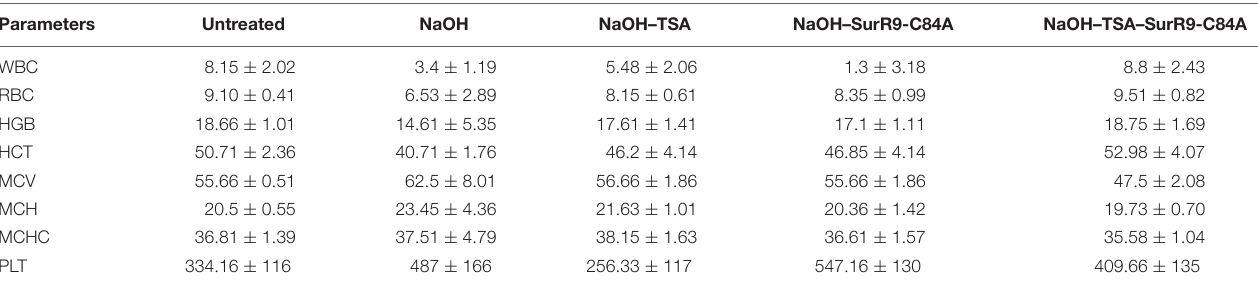
FIGURE 5 | Histology analysis for signs of toxicity: The vital organs from treated and control rats such as brain, spleen, liver, kidney and heart were analyzed using H&E staining for signs of toxicity post-insult with NaOH and treatments with TSA, SurR9-C84A and TSA+SurR9-C84A (SR9). The H&E staining was performed on five slides obtained from each animal and a representative image has been presented. TABLE 4 | Blood